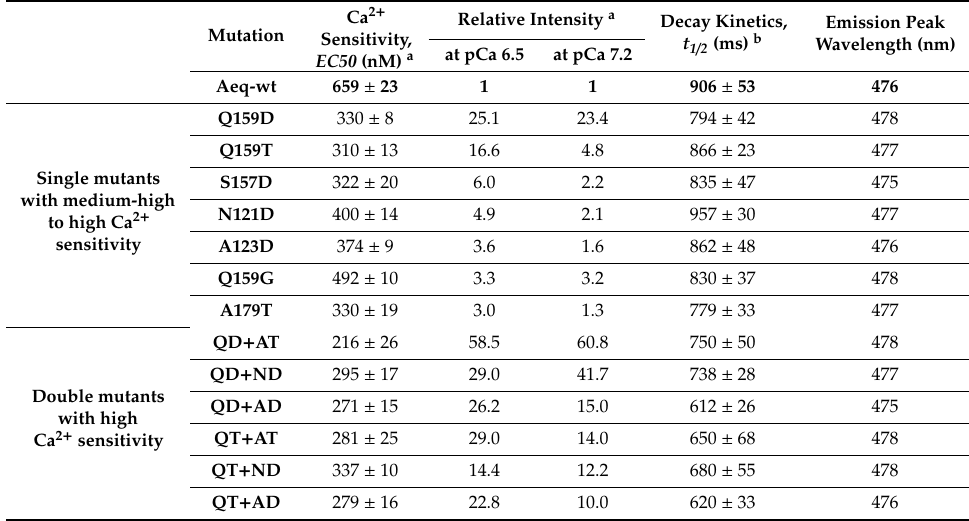
Decay Kinetics, t 1 / 2 (ms)